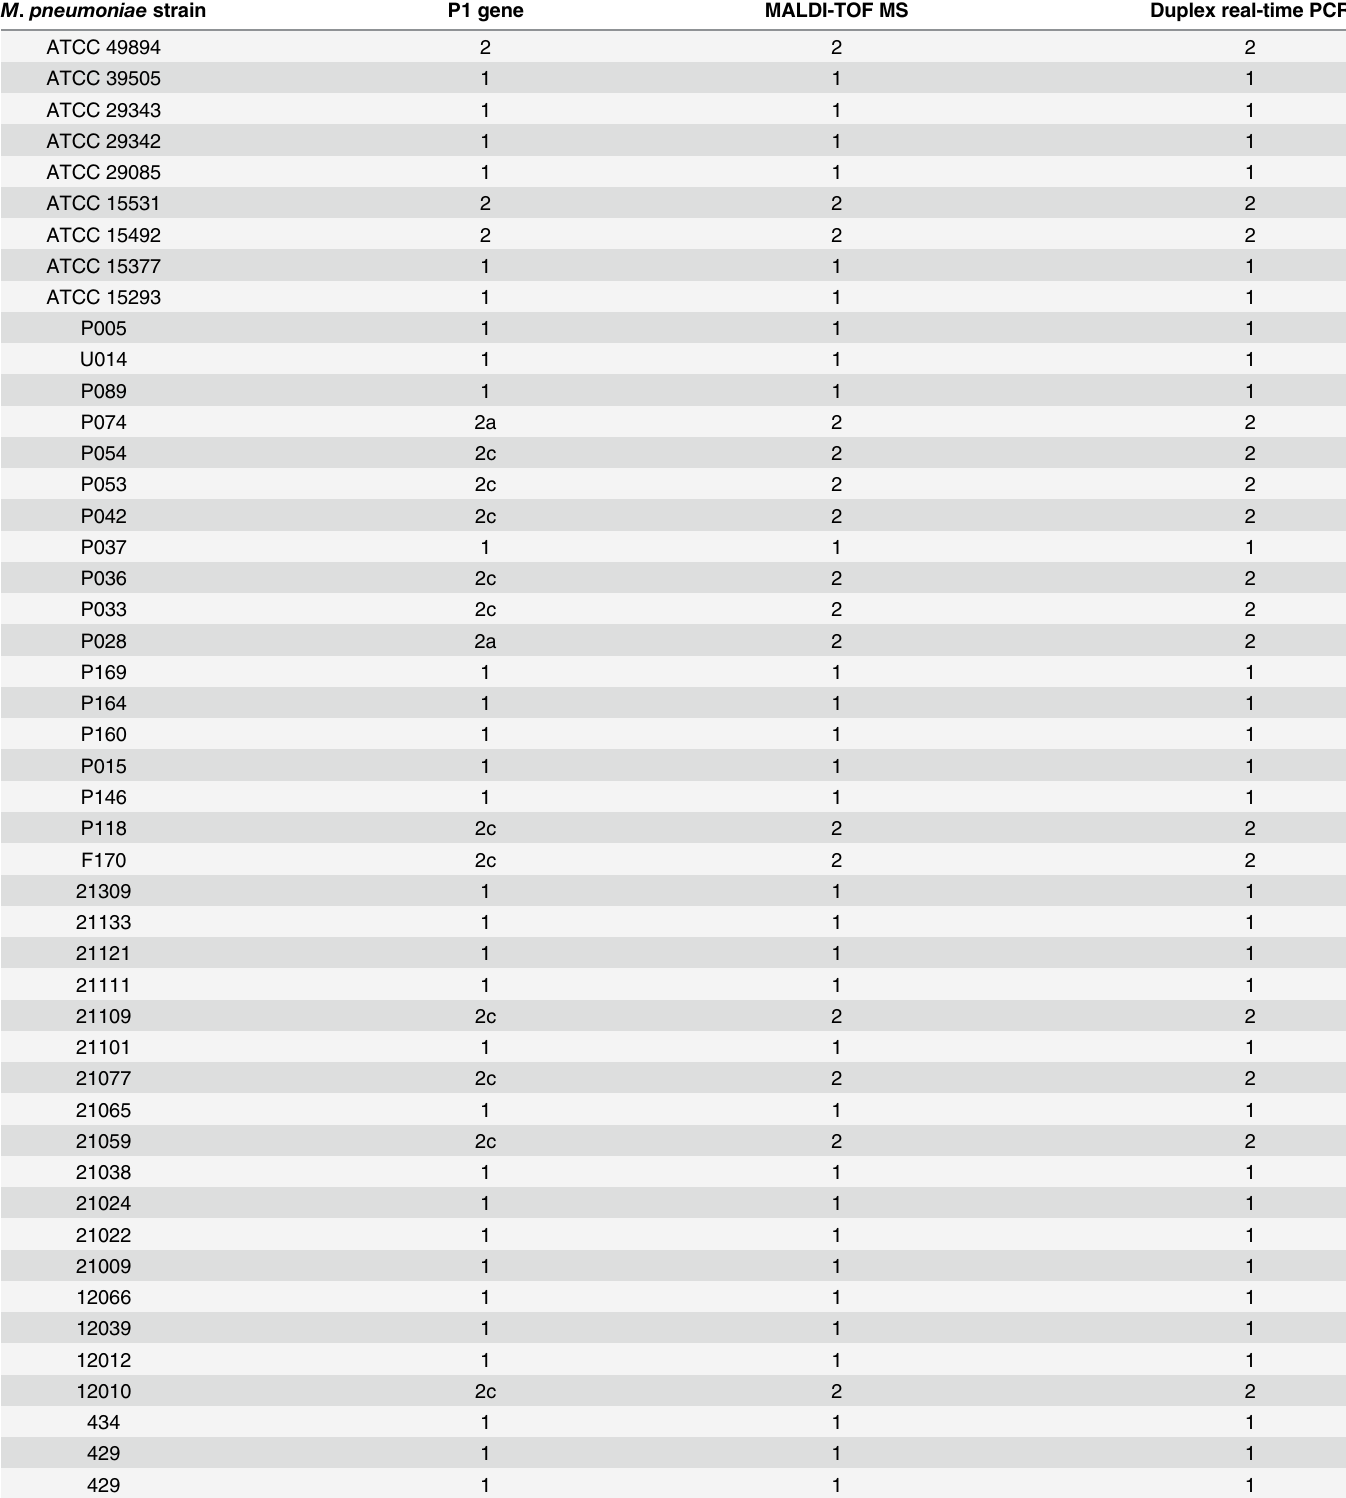
Table 4. Genotypes of 65 M . pneumoniae strains by culture-based and duplex real-time PCR